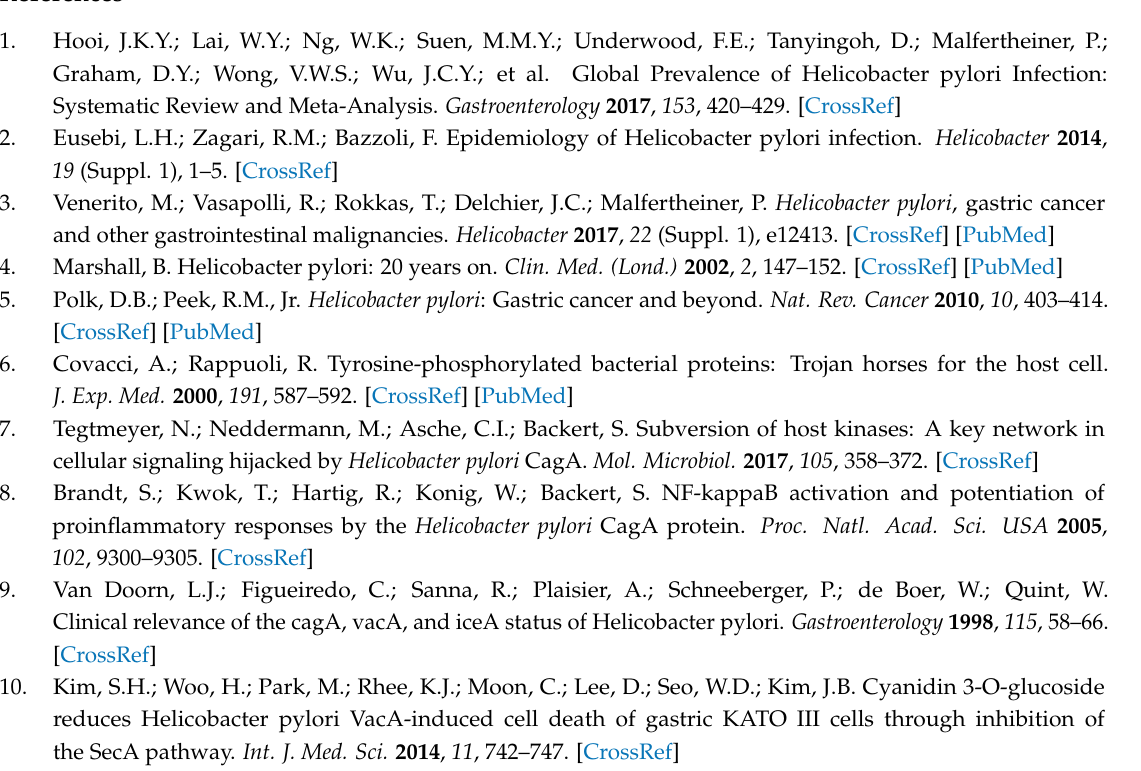
Figure S1: Flowchart of the screening process and experimental procedure. Figure S2: Identification of GMNL-74 and GMNL-185. (A) Represents partial 16S rDNA sequences of Lactobacillus strains GMNL-74 (upper panel) and GMNL-185 (lower panel). (B) Represents RAPD profiles of GMNL-74 and GMNL-185, Figure S3: Agar disk diffusion method to analyze the inhibition activity of standard antibiotics and Lactobacillus strains on H. pylori 26695 strain, Figure S4: Hummingbird phenotype and vacuolization assay, Figure S5: CLO test for analyzing H. pylori infection in mouse stomach, Figure S6: The mean intensity of COX-2 and TNF- α expression for IHC staining in gastric tissues was determined using TissueFAXS. The percentage of cells positive for staining were calculated and shown in the upper right side of each sample, Figure S7: qRT-PCR analysis was performed to identify bacterial phylum: (A) Bacteroidetes , (B) Actinobacteria , (C) Firmicutes , (D) Prevotella , (E) Fusobacteria , and genus (F) Enterococcus , (G) Lactobacillus, (H) Clostridium cluster I. Table S1: Fermentation of carbohydrates was determined using API 50 CHL to identify Lactobacillus and related